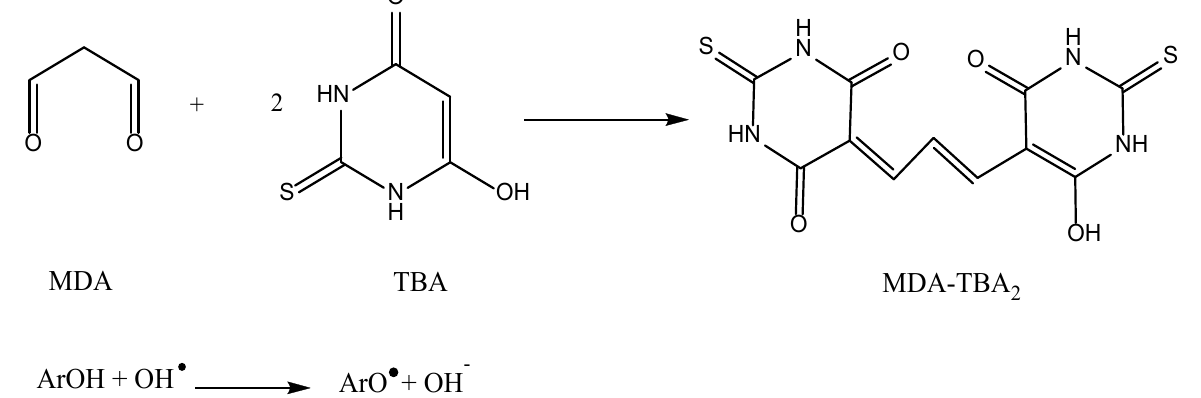
Figure 15. Presentation of the formation reaction of MA-TBARS [26,101].